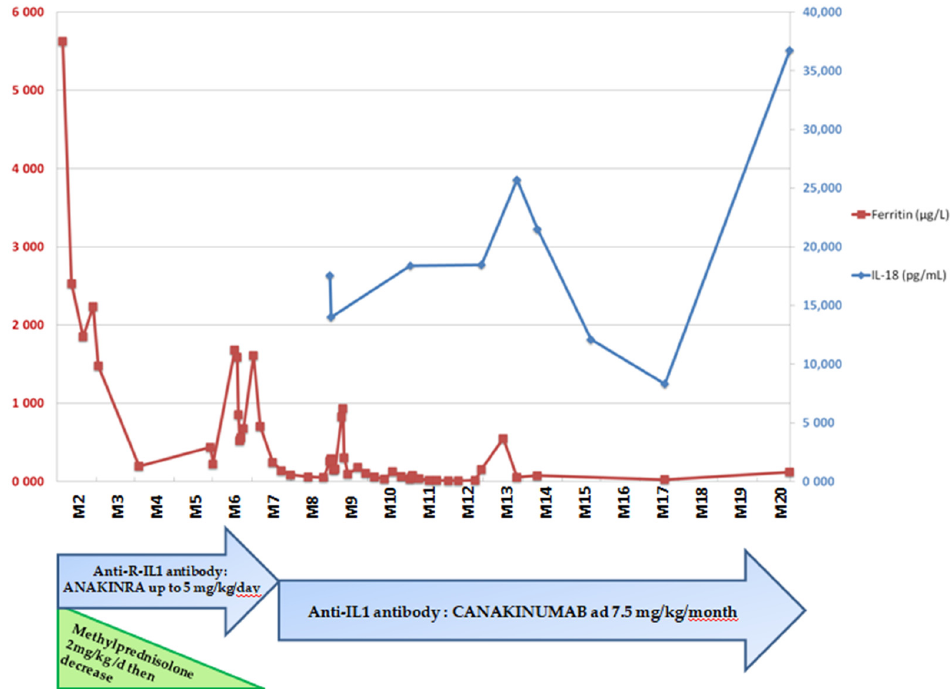
Figure 2. IL-18 and ferritin levels over time and management of patient 1.